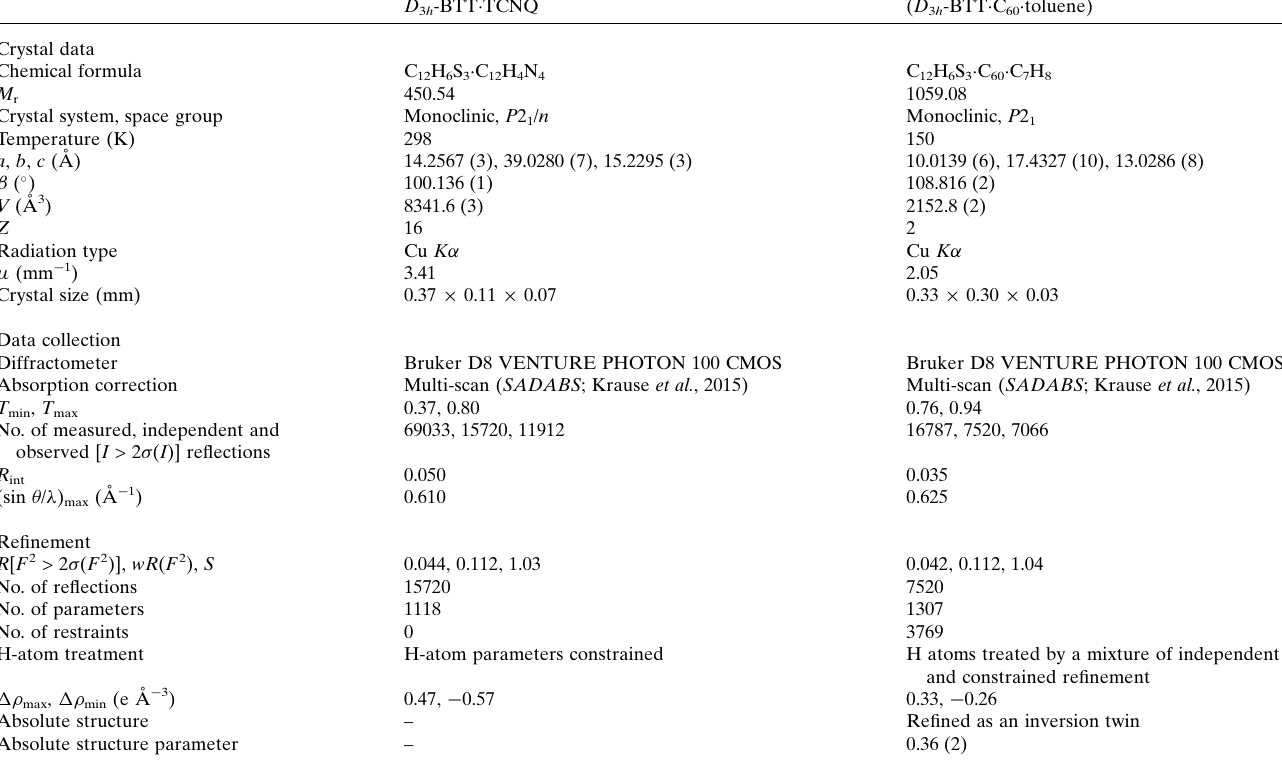
Table 1 Experimental